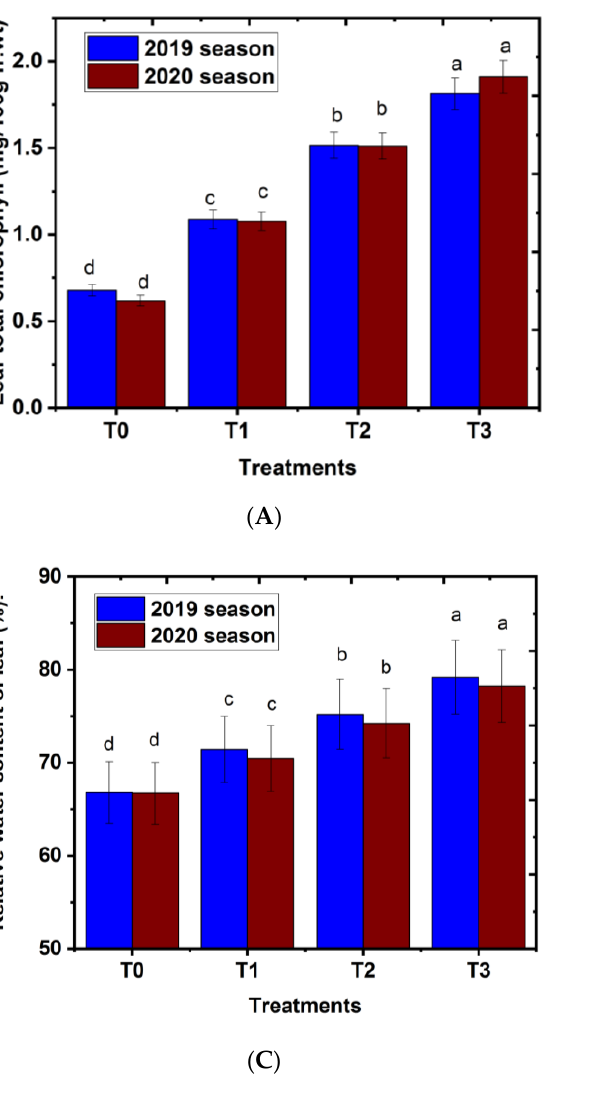
Figure 2. Effect of magnetic iron application on ( A ) leaf total chlorophyll content (mg.100 g −1 Fr.Wt), ( B ) leaf proline content (mg.100 g −1 Fr.Wt), ( C ) Relative water content of leaf (%). and ( D ) total phenolic (mg.GAE −1 .g −1 ) of ‘Chinese’ mandarin trees d uring 2019 and 2020 seasons. T0: 0 g magnetic iron.tree −1 , T1: 250 g magnetic iron.tree −1 , T2: 500 g magnetic iron.tree −1 , and T3: 750 magnetic iron.tree −1 . Bars indicate mean values ± SE ( n = 9). Different letters above columns indicate significant differ- ences among magnetic iron treatments at p = 0.05 according to Bartlett’s test.